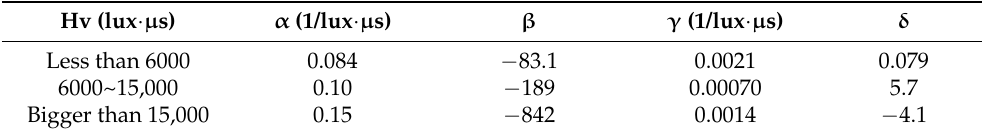
Table 1. Table of